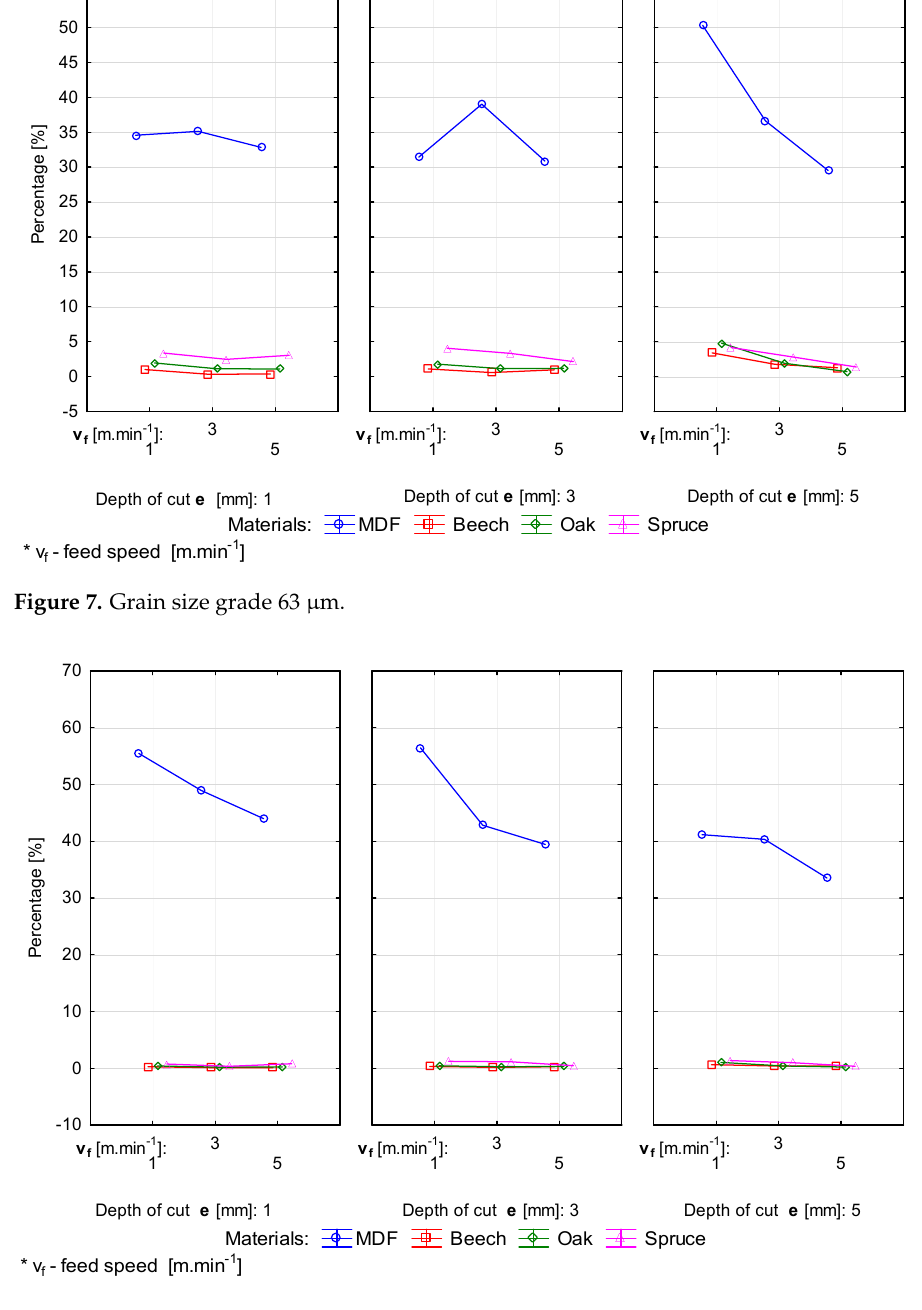
Figure 8. Grain size grade 32 μ m.